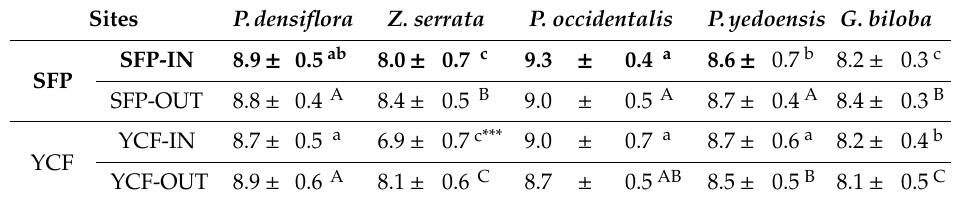
Table 3. Assessment of air pollution tolerance index (APTI) on selected five tree species in urban forests (SFP-IN, YCF-IN) and roadsides (SFP-OUT, YCF-OUT) at Seoul Forest Park (SFP) and Yangjae Citizen’s Forest (YCF).